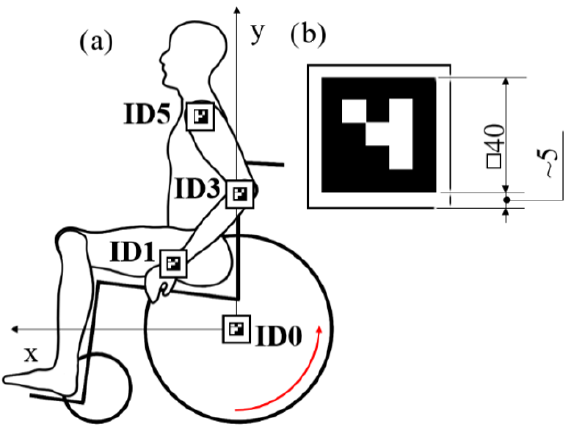
Figure 6. Markers used for motion capture ( a ) placement on the test participant and ( b ) dimen- sions.